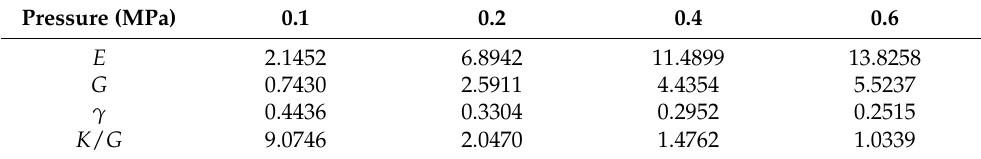
Table 4. Mechanical parameters of the amorphous cellulose region–water model for different pressures. Pressure